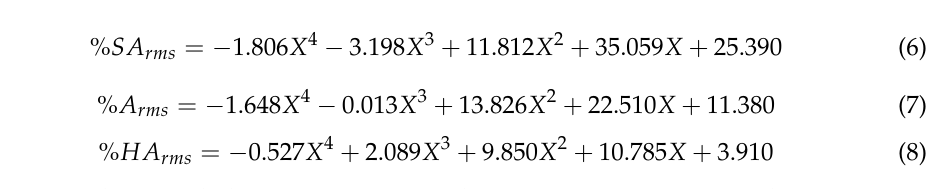
Figure 15. Annoyance rate for the rm s ( -weighted root - mean - square acceleration over the en- tire evaluation period) indicator. evaluation period)